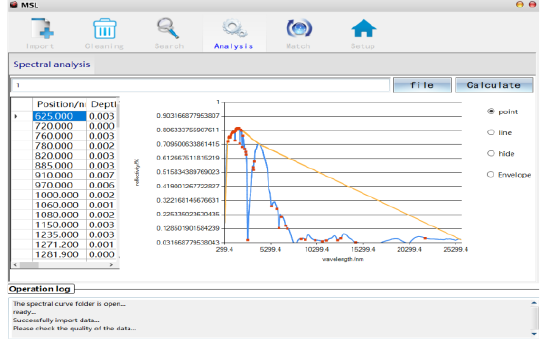
Figure 9. Interface of data import